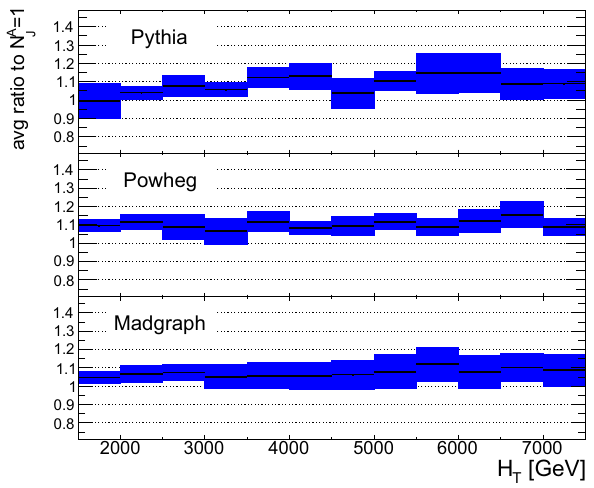
Fig. 7 Weighted average deviation for each generator for H T bins of 500 GeV using jet multiplicities of N A through 6. Blue error bars mark the weighted standard deviation of the 12 datapoints